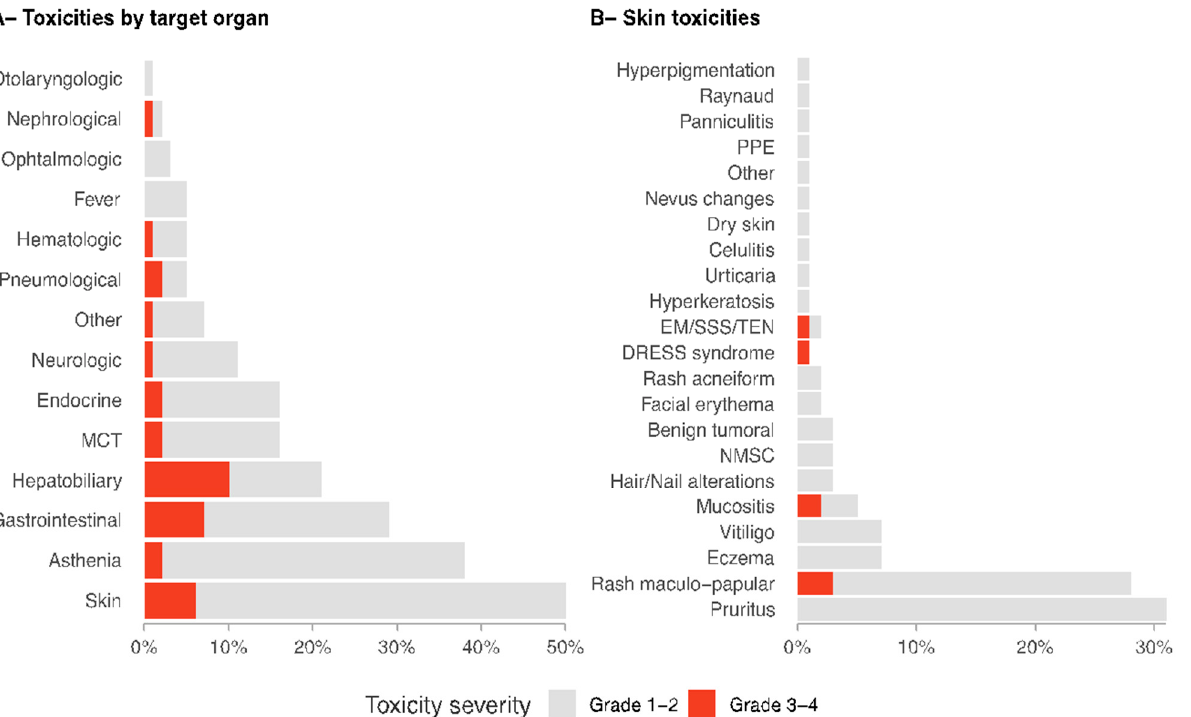
Figure 1. Details of toxicities box plots showing the percentage of patients who presented specific toxicities. Panel A shows the frequency of immune-related adverse events (irAEs) stratified by target organs. Fever and asthenia were considered as target symptoms due to the frequency of these side effects. Panel B shows dermatological irAEs in detail. Abbreviations: EM, erythema multiforme; MCT, musculoskeletal and connective tissue; PPE, palmar-plantar erythrodysesthesia; NMSC, non-melanoma skin cancer; SSS, Stevens-Johnson syndrome; TEN, toxic epidermal necrolysis.